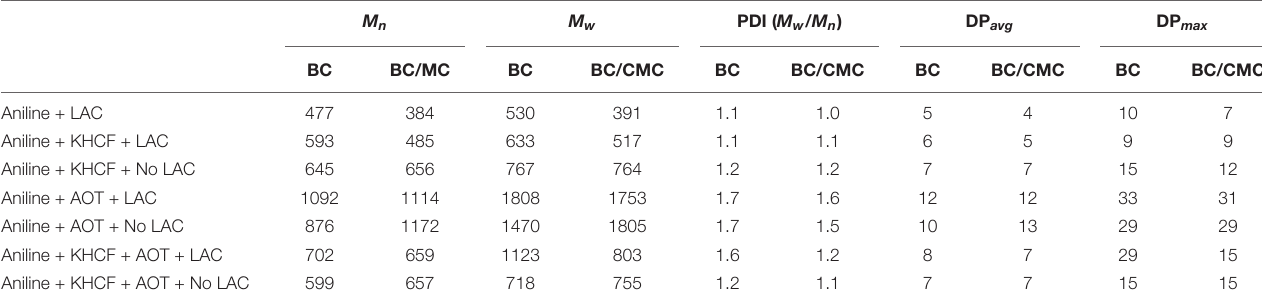
TABLE 3 | Polyaniline characterization in terms of Mn , Mw , average polymerization degree (DP avg ) and maximum degree of polymerization (DP max ) after laccase oxidation on BC and on BC/CMC under different conditions (the data is obtained from MALDI-TOF analysis; aniline (M w ) = 93,13